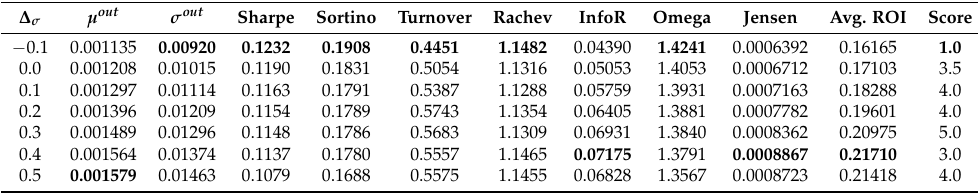
Table 17. CIB: out-of-sample performance results for the RMZ R strategy by varying ∆ σ (with ∆ γ =